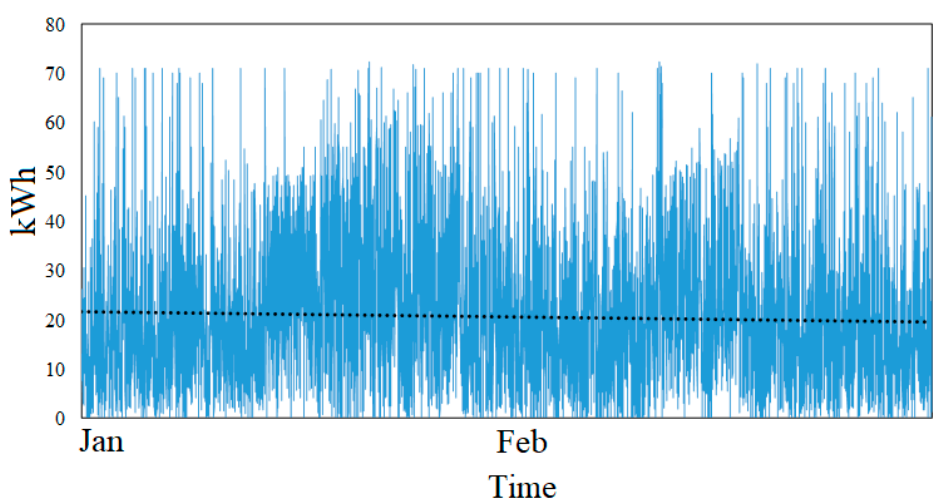
Figure 2. The half hourly RTG demand (blue line) with linear model fit to the data (dotted).